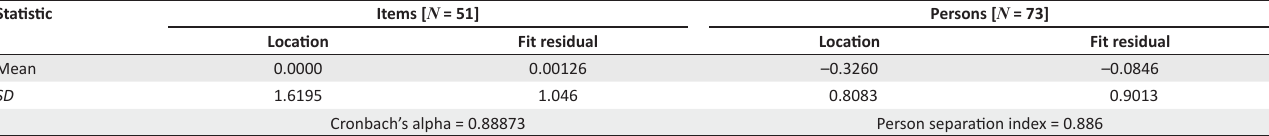
TABLE 2 : Final summary statistics.